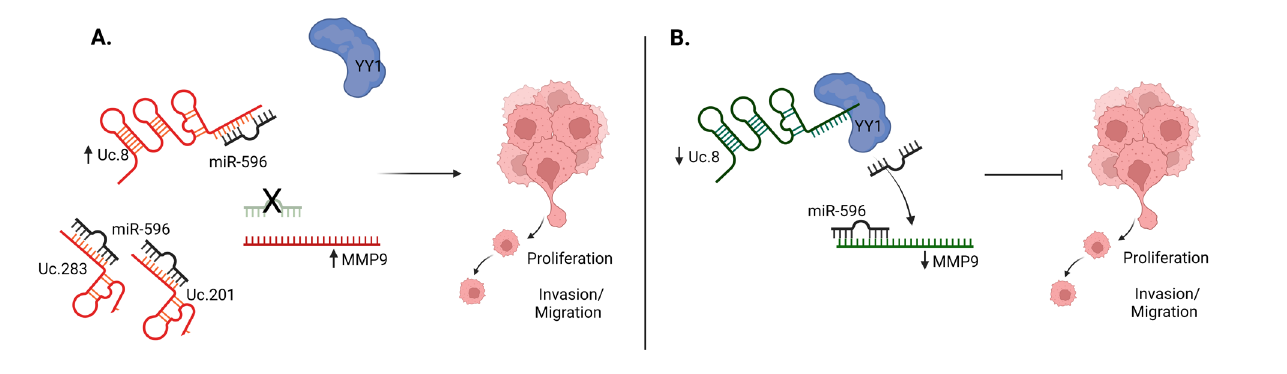
Figure 2 – Mechanism of action of Uc.8, Uc.201, and Uc.283. A. In cancer cells, Uc.8, Uc.201, and Uc.283 high expression induce invasion/migration and proliferation. B. Uc.8 silencing decreased invasion/migration and proliferation. Green molecules meaning low expression and red meaning high expression. Created with